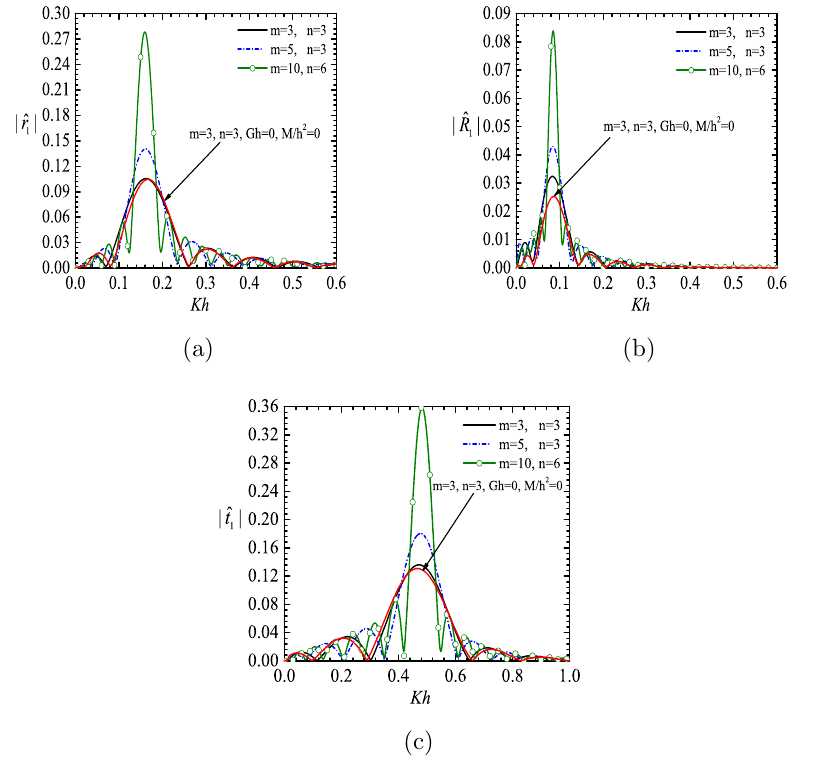
(cid:12) (cid:12) (cid:12) (cid:12) (cid:12) (cid:12) (cid:12)(cid:98) t 1 (cid:12) for (cid:12) (cid:98) R 1 (cid:12) ; (c)